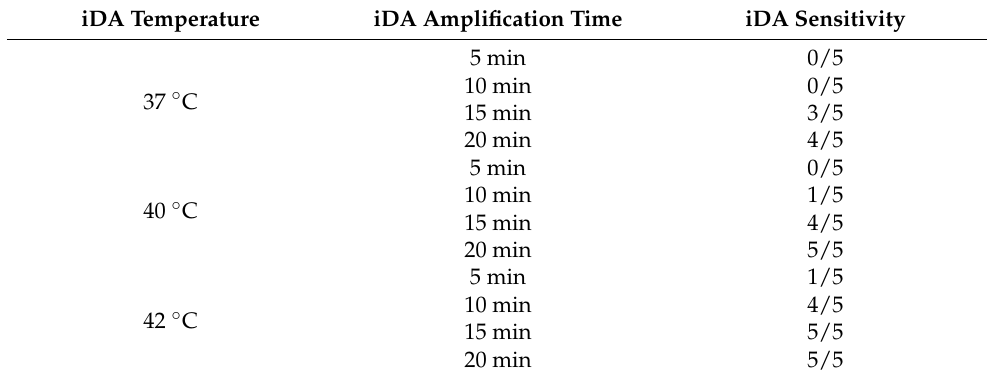
Table 2. Effect of amplification time and temperature on iDA.